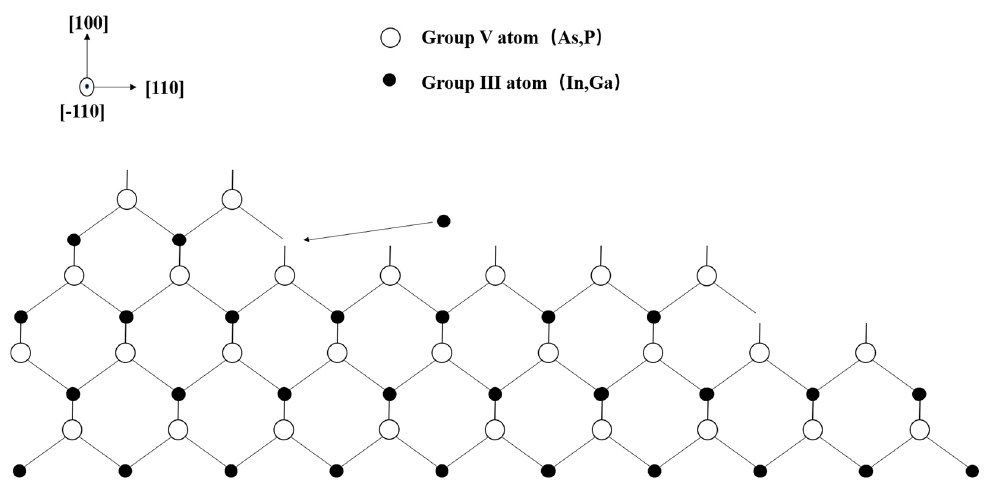
Figure 5. Schematic illustration of the growth process.